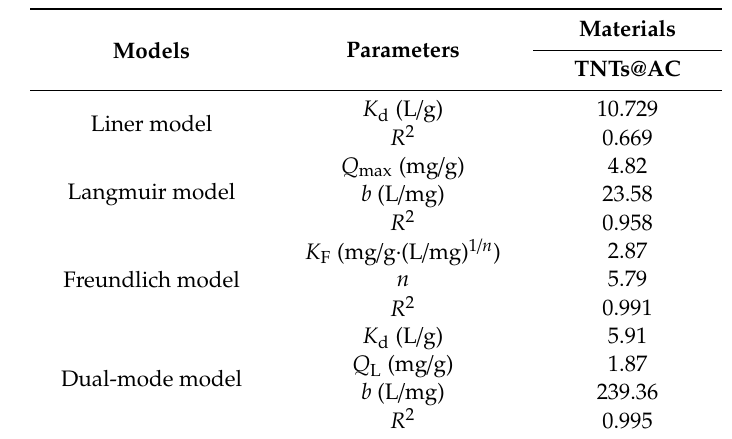
Table 2. Parameters of isotherm models for E2 (0.25−3.0 mg/L) adsorption onto TNTs@AC.